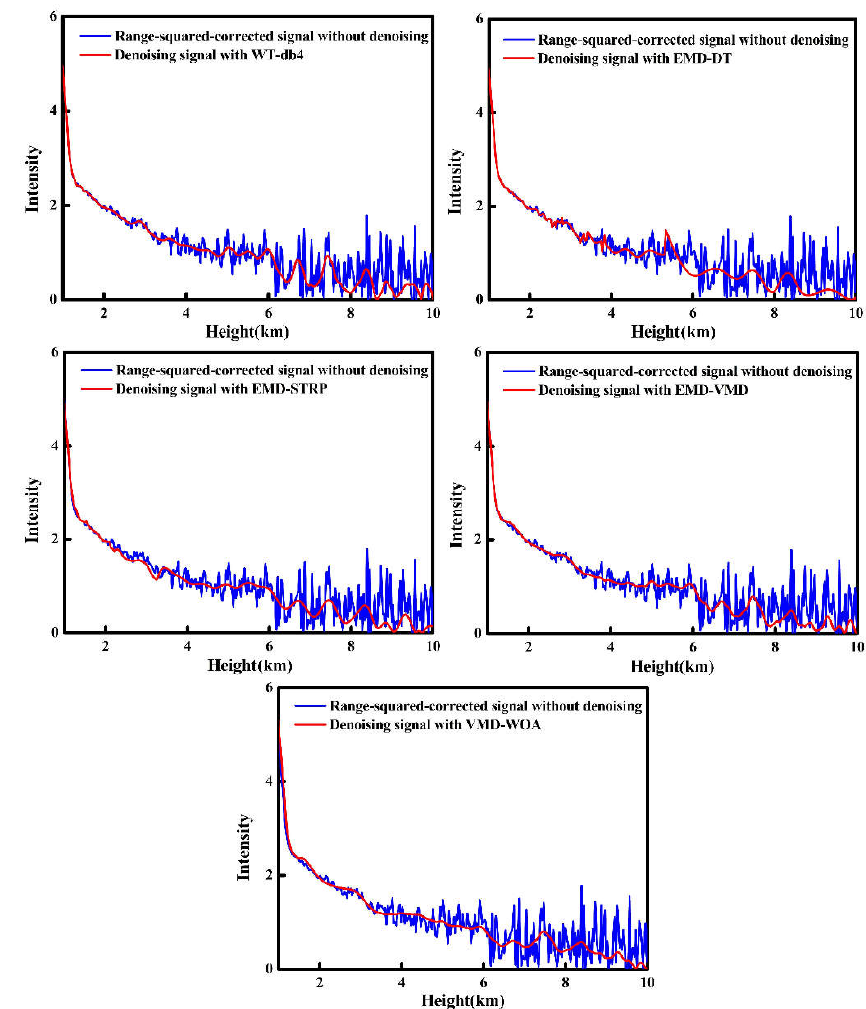
Figure 9. Comparison of the VMD-WOA and the other methods for the range-squared-corrected signal.